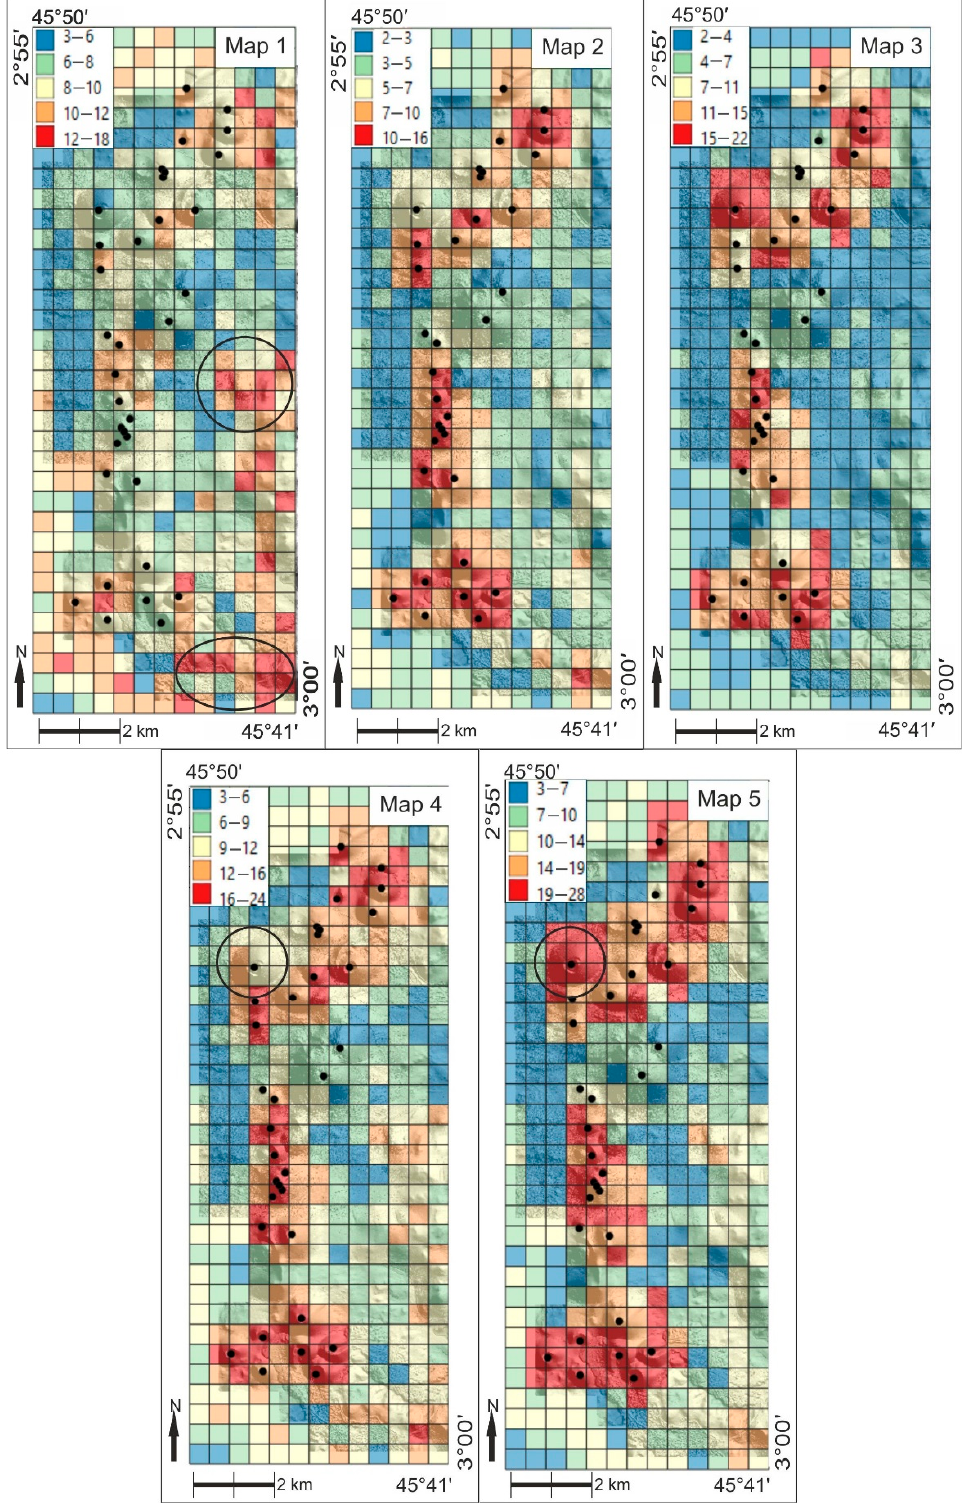
Figure 11. Comparison of the calculated geodiversity maps (see above).